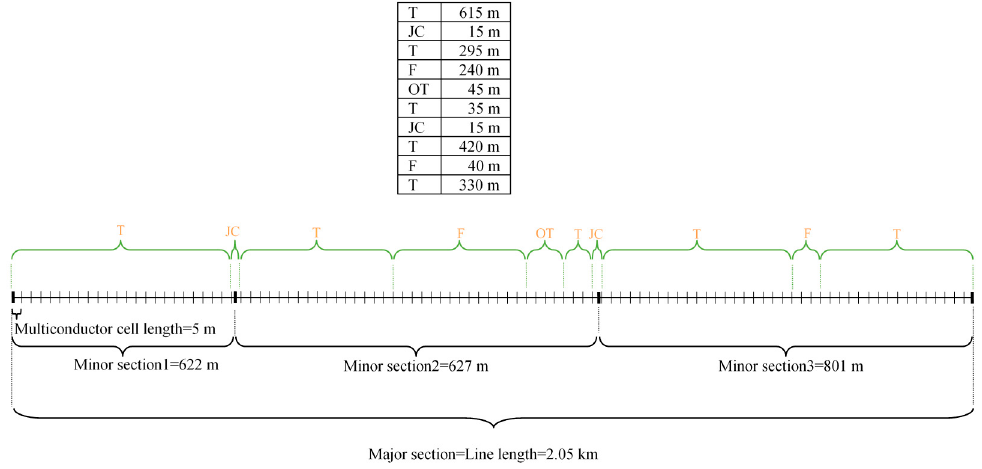
Figure 9. Subdivision of case #3 in elementary cells, minor and major sections. OT—open trefoil with spacing = 0.18 m; F1—flat laying with spacing = 0.25 m; F2—flat laying with spacing = 0.5 m; T—close trefoil.